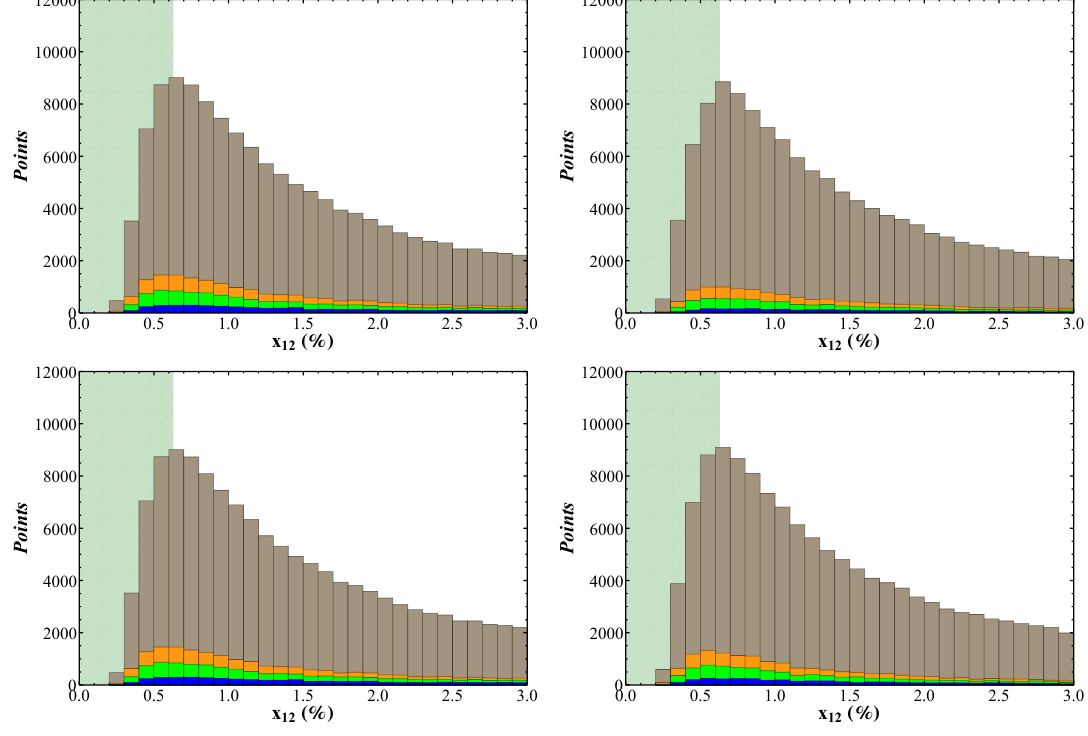
Figure 13. Histograms of the x 12 , for g A = g B = 0 : 1 and v F =k = 0 : 1 (top left), g A = g B = 1 : 0 and v F =k = 0 : 1 (top right), g A = g B = 0 : 1 and v F =k = 1 : 0 (bottom left), and g A = g B = 1 : 0 and v F =k = 1 : 0 (bottom right). The blue represents points which satisfy the 68% CL experimental limit in the h d (cid:0) (cid:27) d plane, the green represents the 95% CL region, the orange represents the 99.7% CL region, and the beige includes all points in our sample pool, with no h d (cid:0) (cid:27) d